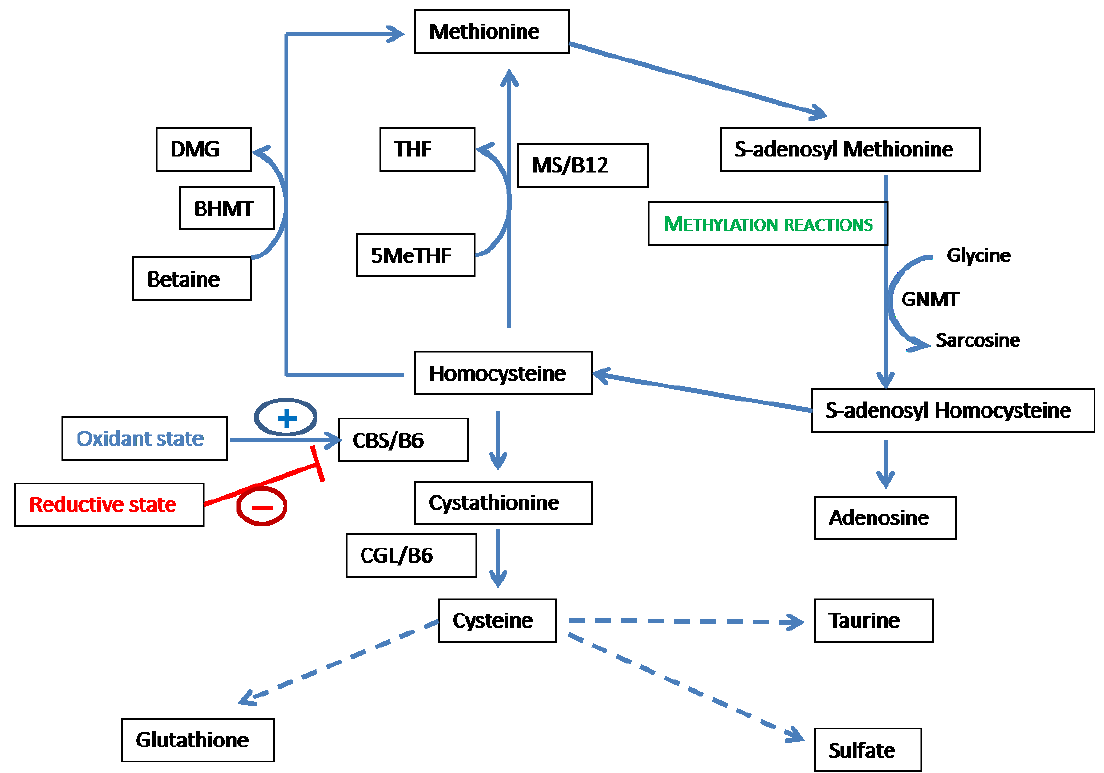
Figure 1. Methionine-homocysteine cycle is closely linked to redox balance, methylation, and sulfur amino-acid